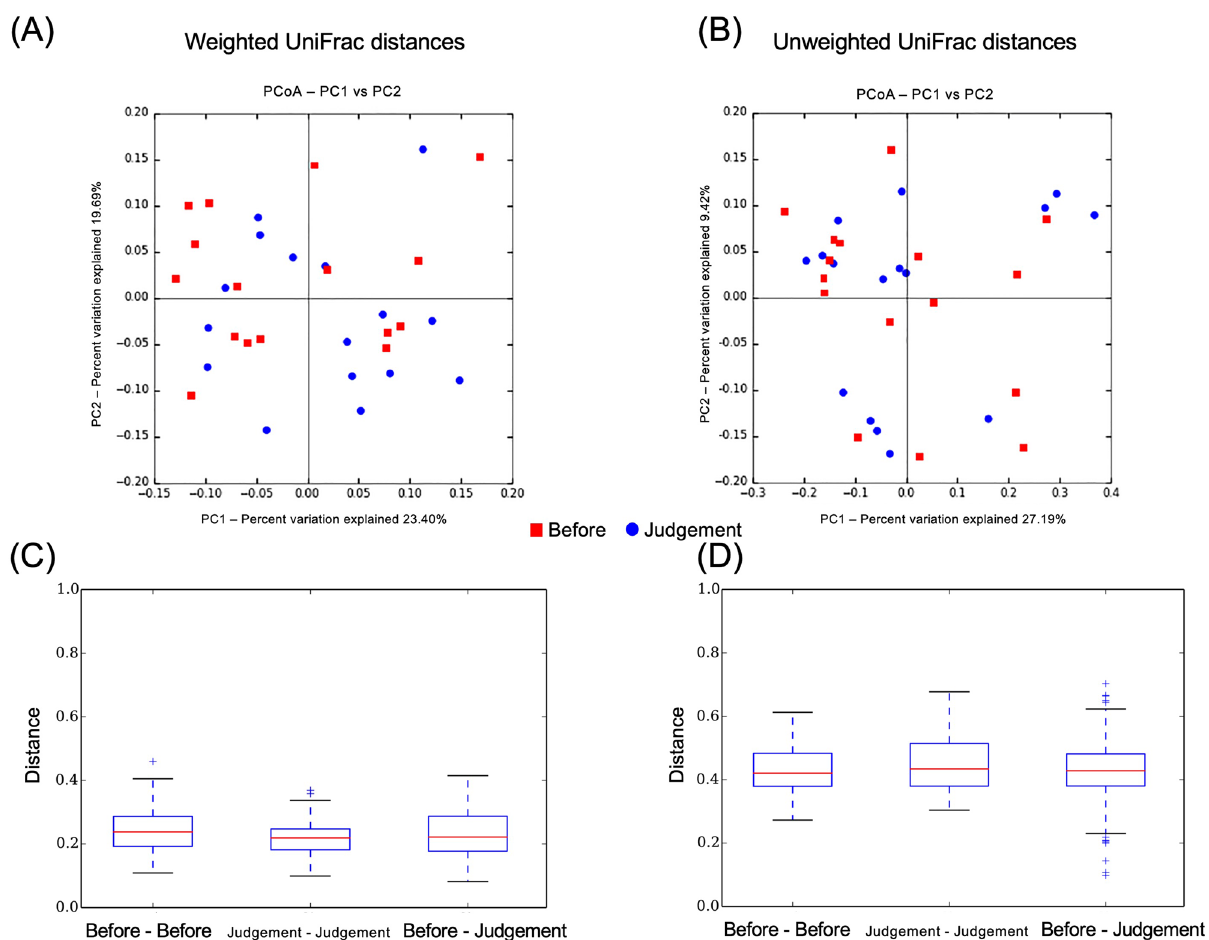
Figure 8. Principal coordinates analysis revealed clustered communities of gut microbiota after eradication in the before and after eradication therapy groups. ( A ) Weighted UniFrac distances, ( B ) Unweighted UniFrac distances. Bar diagram showing the Mean UniFrac distances for Before–Before, Judgment–Judgment, and Before–Judgment participants. ( C ) Weighted UniFrac distances (Before–Before vs. Before–Judgment, P =